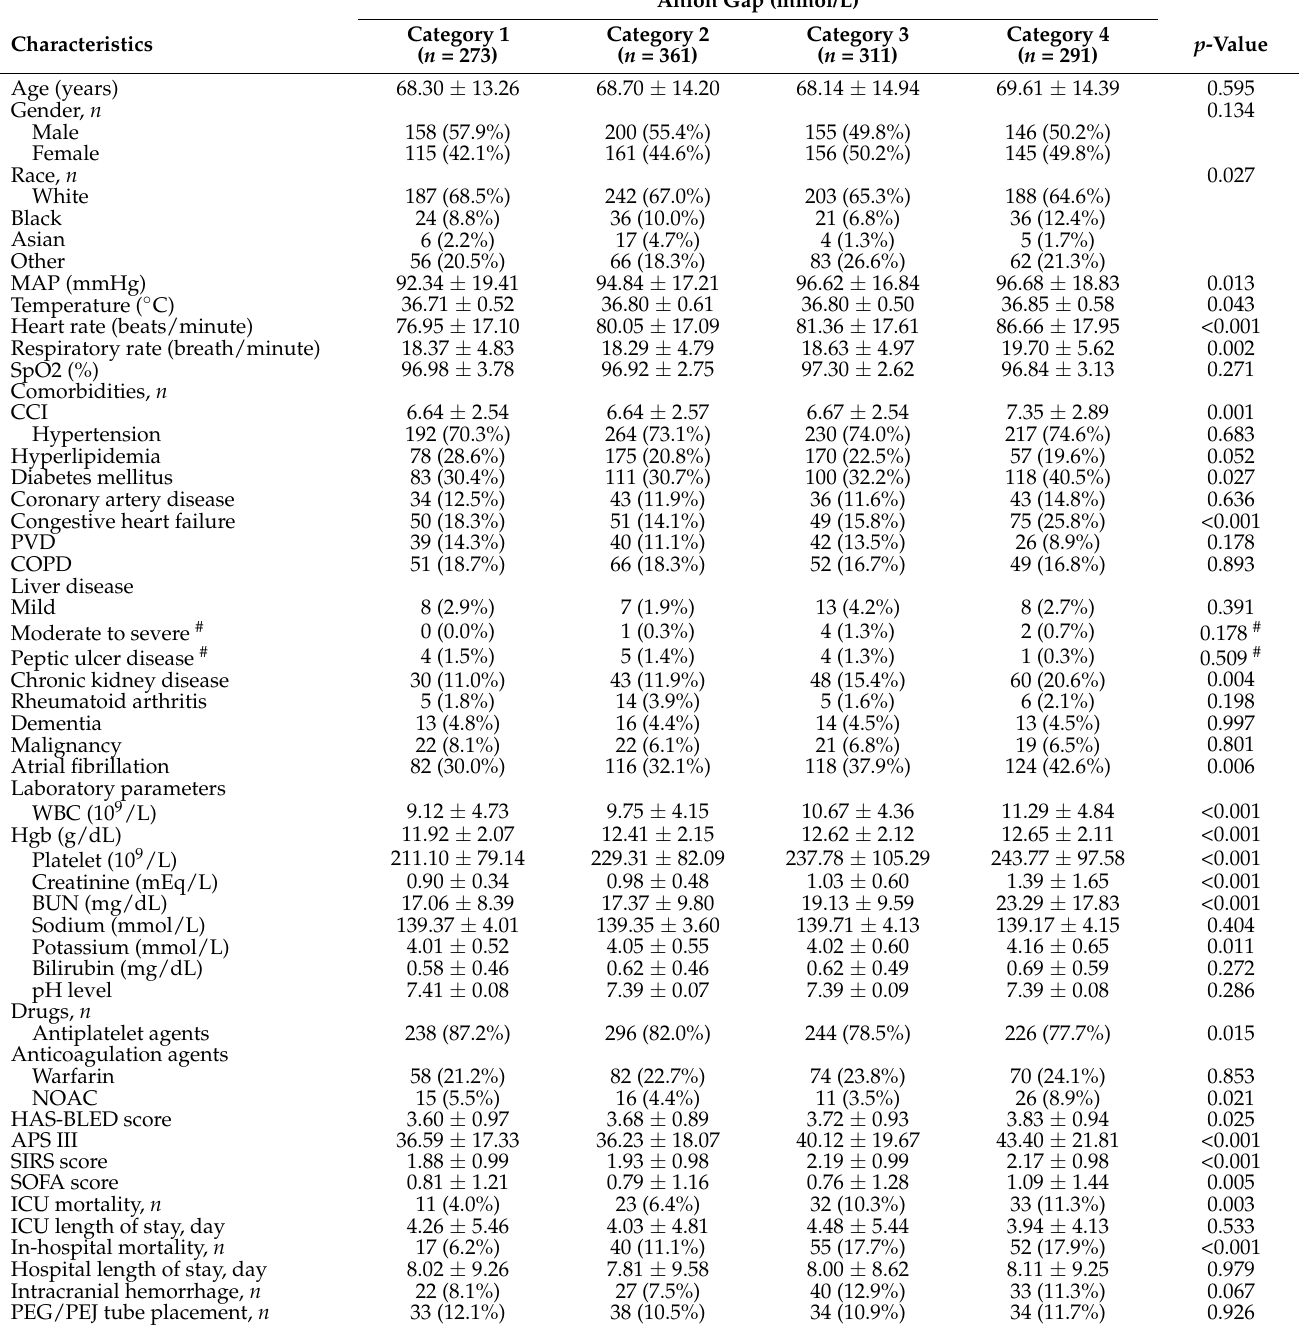
Table 1. Characteristics of the study